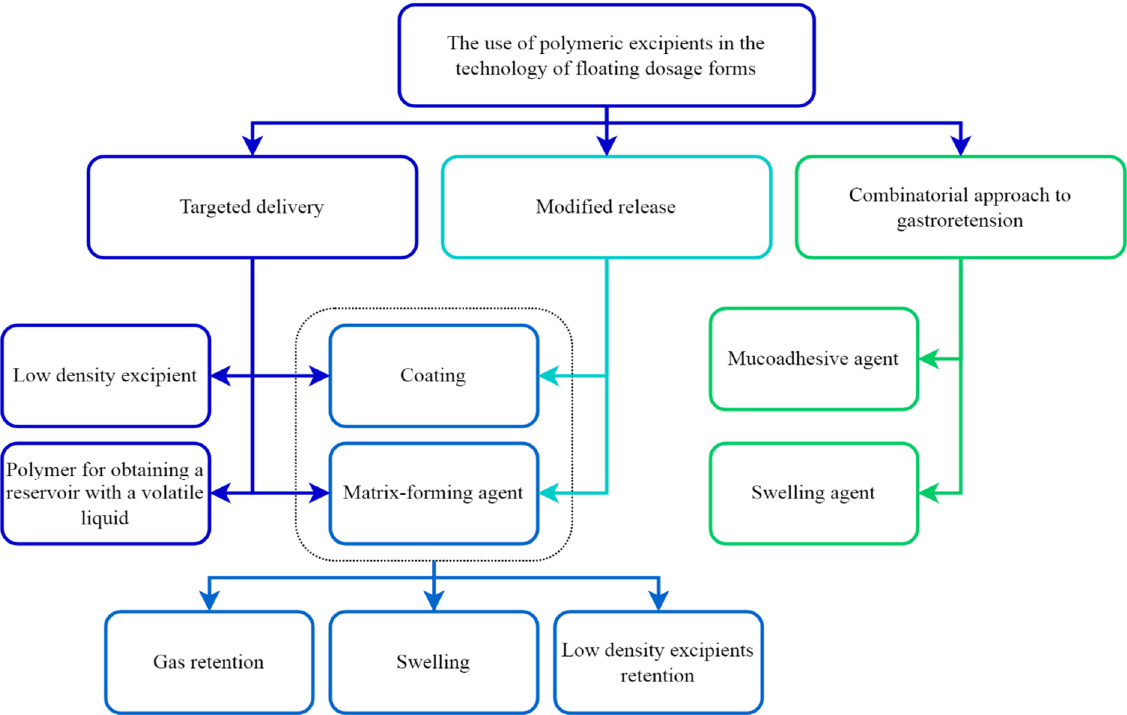
Figure 1. Field of application of polymer excipients in the technology of floating dosage forms.